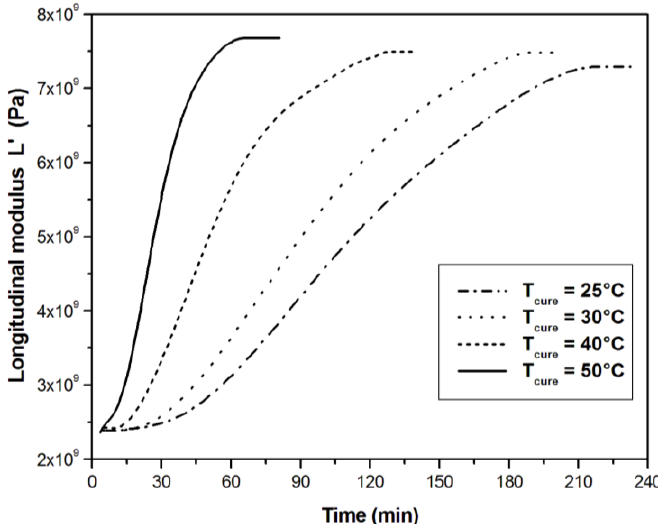
Figure 3. Longitudinal modulus L ' measured at 2 MHz during the isothermal cure of unsaturated polyester resin at different cure